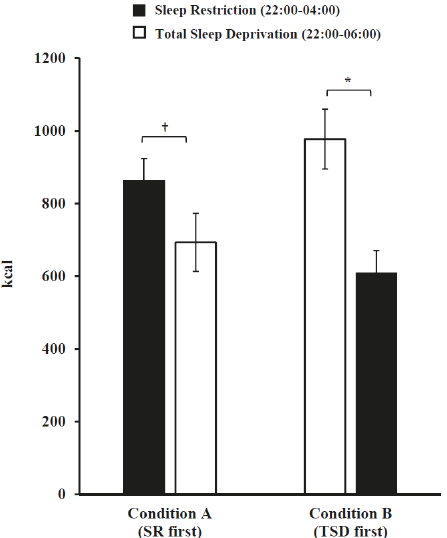
Figure 1. Mean ± SEM late ‐ night caloric intake during sleep restriction (SR) and total sleep deprivation (TSD). There was a significant sleep loss exposure type (SR and TSD) × condition (A and B) interaction ( p < 0.001), but no main effect of condition ( p = 0.85). In both conditions, participants consumed more late ‐ night calories during their first sleep loss exposure; however, this was statistically significant for Condition B (* p < 0.001), but not for Condition A († p = 0.08).